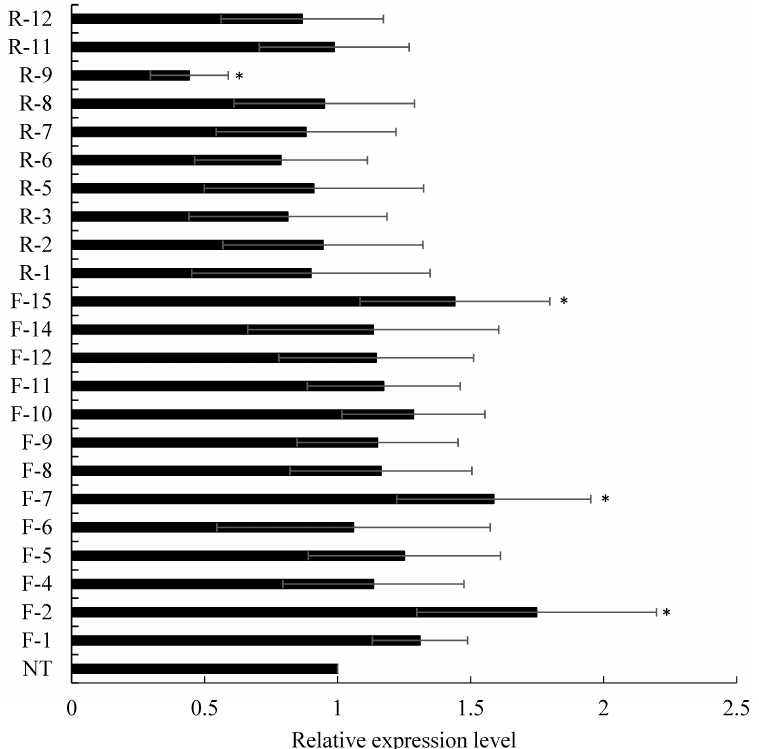
Figure 5. qPCR analysis of ScD27.2 gene expression in transgenic lines. NT, non-transgenic lines; ScD27.2F-2, sense overexpression lines; ScD27.2R-9, antisense interference lines. R-1 to 12 are PCAMBIA3301-ScD27 antisense lines; F-1 to F-15 are PCAMBIA3301-ScD27 sense lines. * indicate